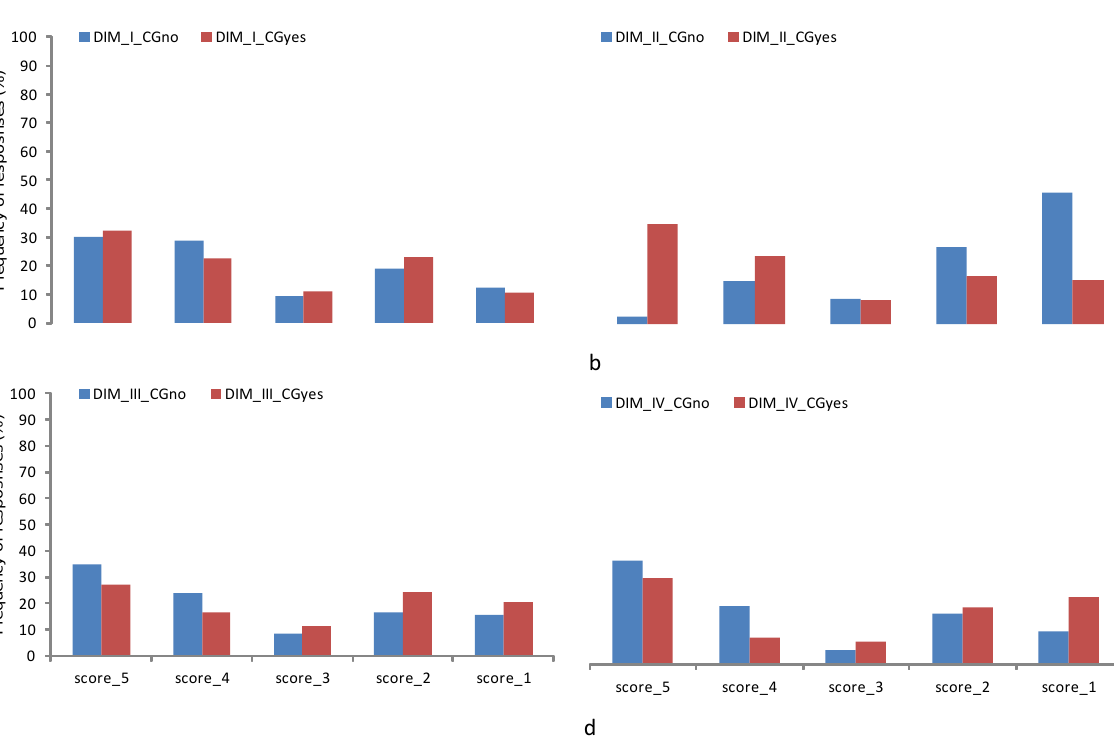
Figure 5. IG frequency of responses (%) for the 5 scores of the Likert scale in each of the four attitudes dimensions: DIM I (a), DIM II (b), DIM III (c) and DIM IV, (d) and for the IG before and after participation.